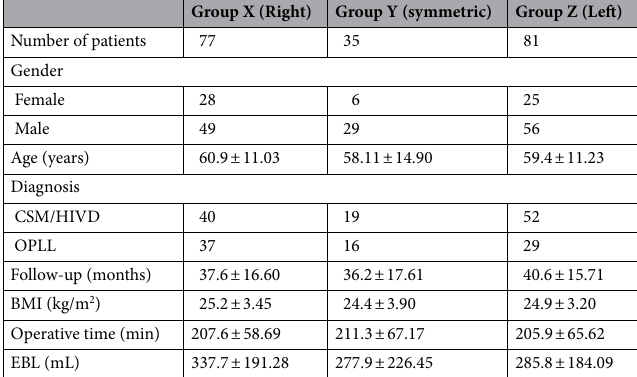
Table 5. Patient characteristics based on dominant radiculopathy symptom side. CSM indicated cervical spondylotic myelopathy; HIVD herniated intervertebral disc; OPLL ossification of posterior longitudinal ligament; BMI body mass index; EBL estimated blood